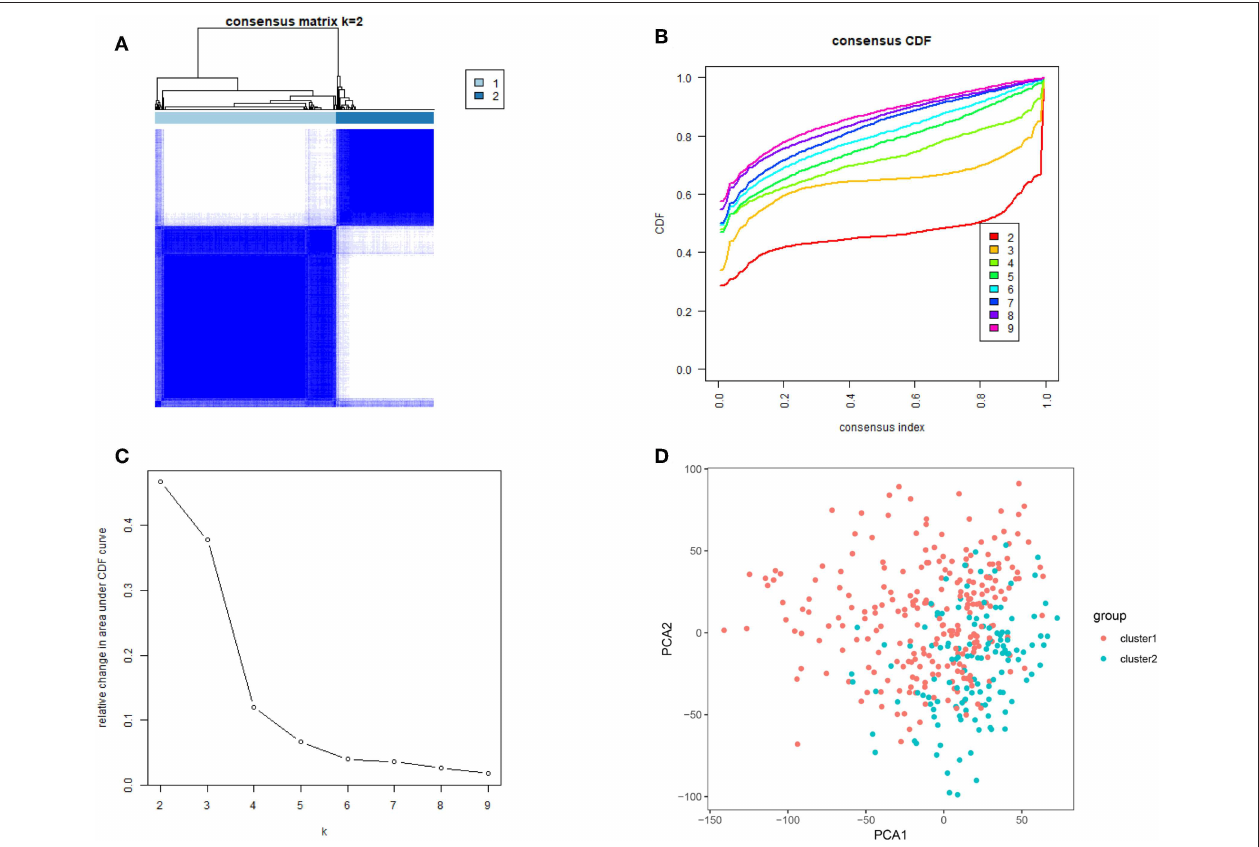
FIGURE 2 | Identification of consensus clusters by m 6 A RNA methylation regulators. (A) Consensus clustering matrix for k = 2; (B) consensus clustering cumulative distribution function (CDF) for k = 2–9; (C) relative change in area under CDF curve for k = 2–9; (D) principal component analysis of the total RNA expression profile in the TCGA dataset. Gastric cancer in the cluster1 subgroup are marked with red, and the cluster2 subgroup are marked with